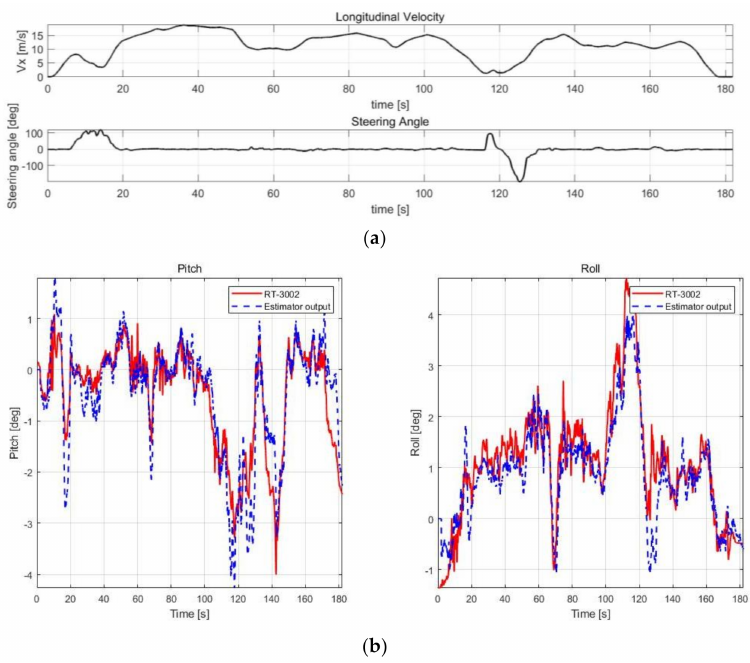
Figure 8. Validation results of Case 4. ( a ) Speed and steering profile. ( b ) Roll/pitch estimation